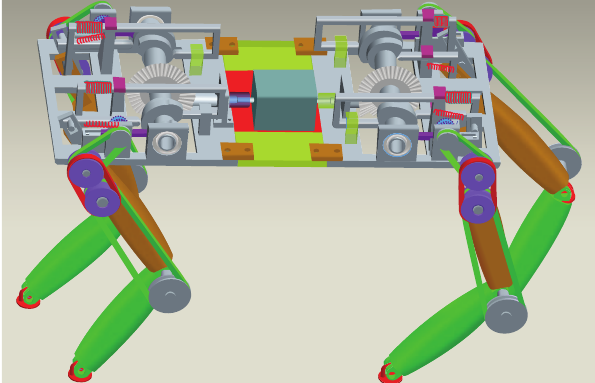
Figure 14: Three-dimensional model of the quadruped robot.